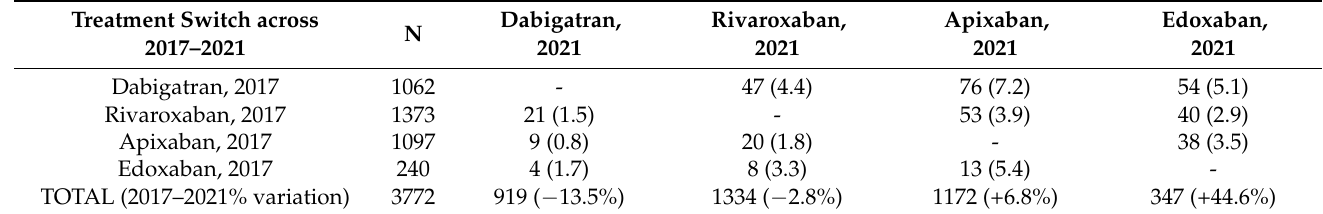
Table 2. Switch of NOAC treatment across 2017–2021 among patients under NOAC (N = 3772). Treatment Switch across